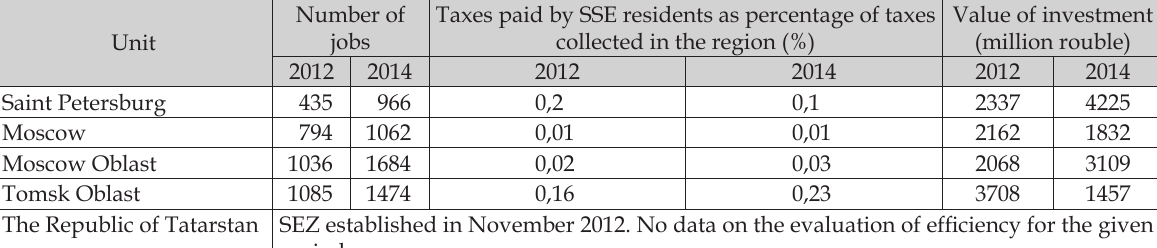
Value of investment